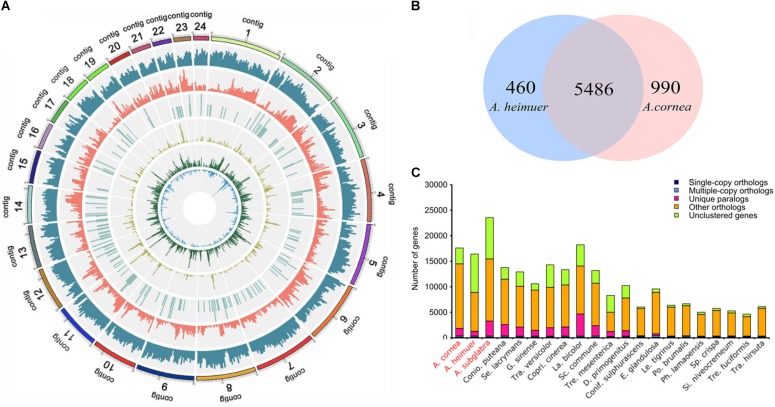
Genome map and gene family analysis of the A. cornea genome. (A) Genome map of A. cornea. Outside to inside of concentric circles show assembly contig number, gene density, all repeat content, non-coding RNA (ncRNA), LINE content, LTR content, and DNA repeat content of AC1 genome. (B) Unique and share gene families in the genomes of A. cornea AC1 and A. heimuer ASM. The number of unique and shared gene families is shown in each of the diagram components. (C) Comparison of orthologous genes among the genomes of 21 fungal species.